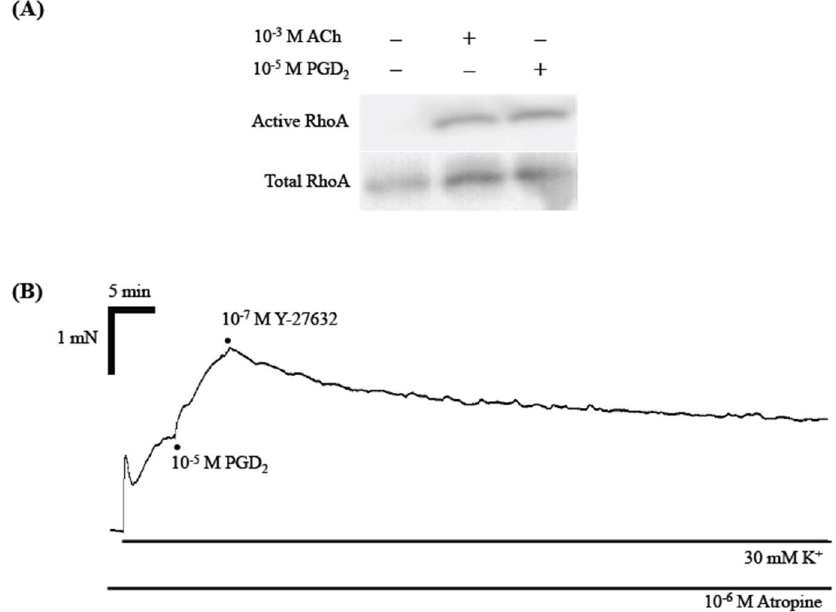
Figure 5. Activation of RhoA/Rho-kinase signaling by prostaglandin D 2 (PGD 2 ) in bronchial smooth muscle (BSM) of the mouse. ( A ) Effect of PGD 2 on the level of GTP-bound active form of RhoA. Freshly isolated BSMs of mice were stimulated with acetylcholine (ACh: 10 − 3 M) or PGD 2 (10 − 5 M) for 10 min, and GTP-RhoA pull-down assay and RhoA immunoblottings were performed as described in Materials and Methods section. The blots for GTP-bound (active: upper ) and total RhoA ( lower ) are shown and representative from 3 independent experiments, respectively. ( B ) Effect of Y-27632 (a selective Rho-kinase inhibitor) on the augmented contraction induced by prostaglandin D 2 (PGD 2 ) in BSMs isolated from mice. After the BSM contraction induced by PGD 2 reached to plateau, 10 − 7 M Y-27632 was applied. A trace of change in the active force is shown and representative from 3 independent experiments.